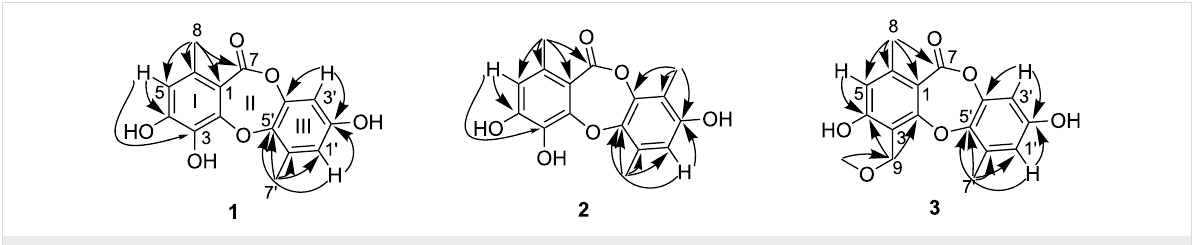
Figure 2: Selected HMBC (arrow) correlations of 1 – 3 .